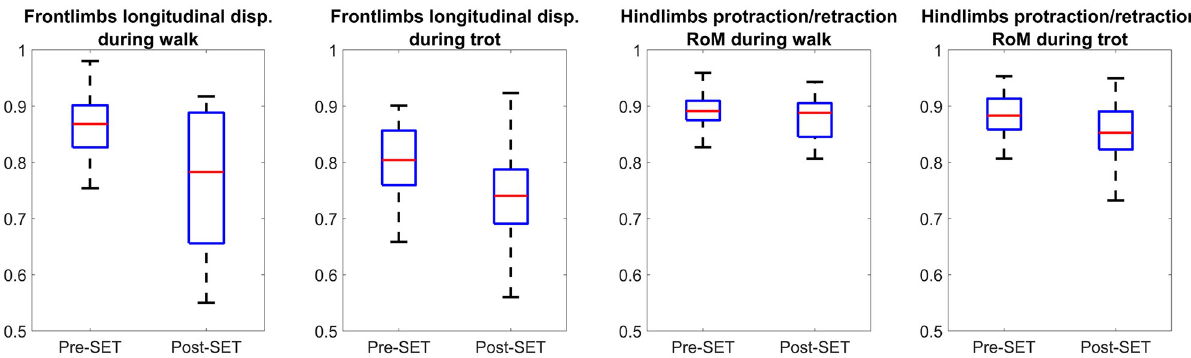
Fig 4. Comparison of biomechanical features of all horses between pre- and post-SET during walk and trot. The vertical axes of all plots represents the range-normalized value of the feature. The box represents the interquartile range, while the red line (horizontal line within the box) shows the median value. Each box (two for each plot) consists of one value per horse, which was averaged from all strides of the horse.